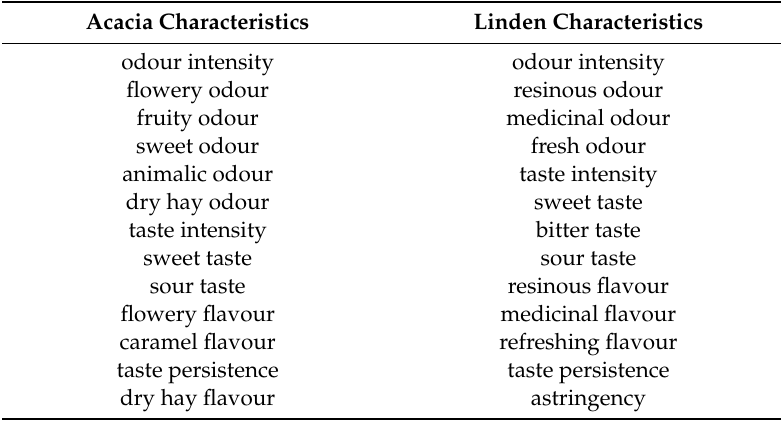
Table 2. Sensory properties of acacia and linden honeys defined by the sensory